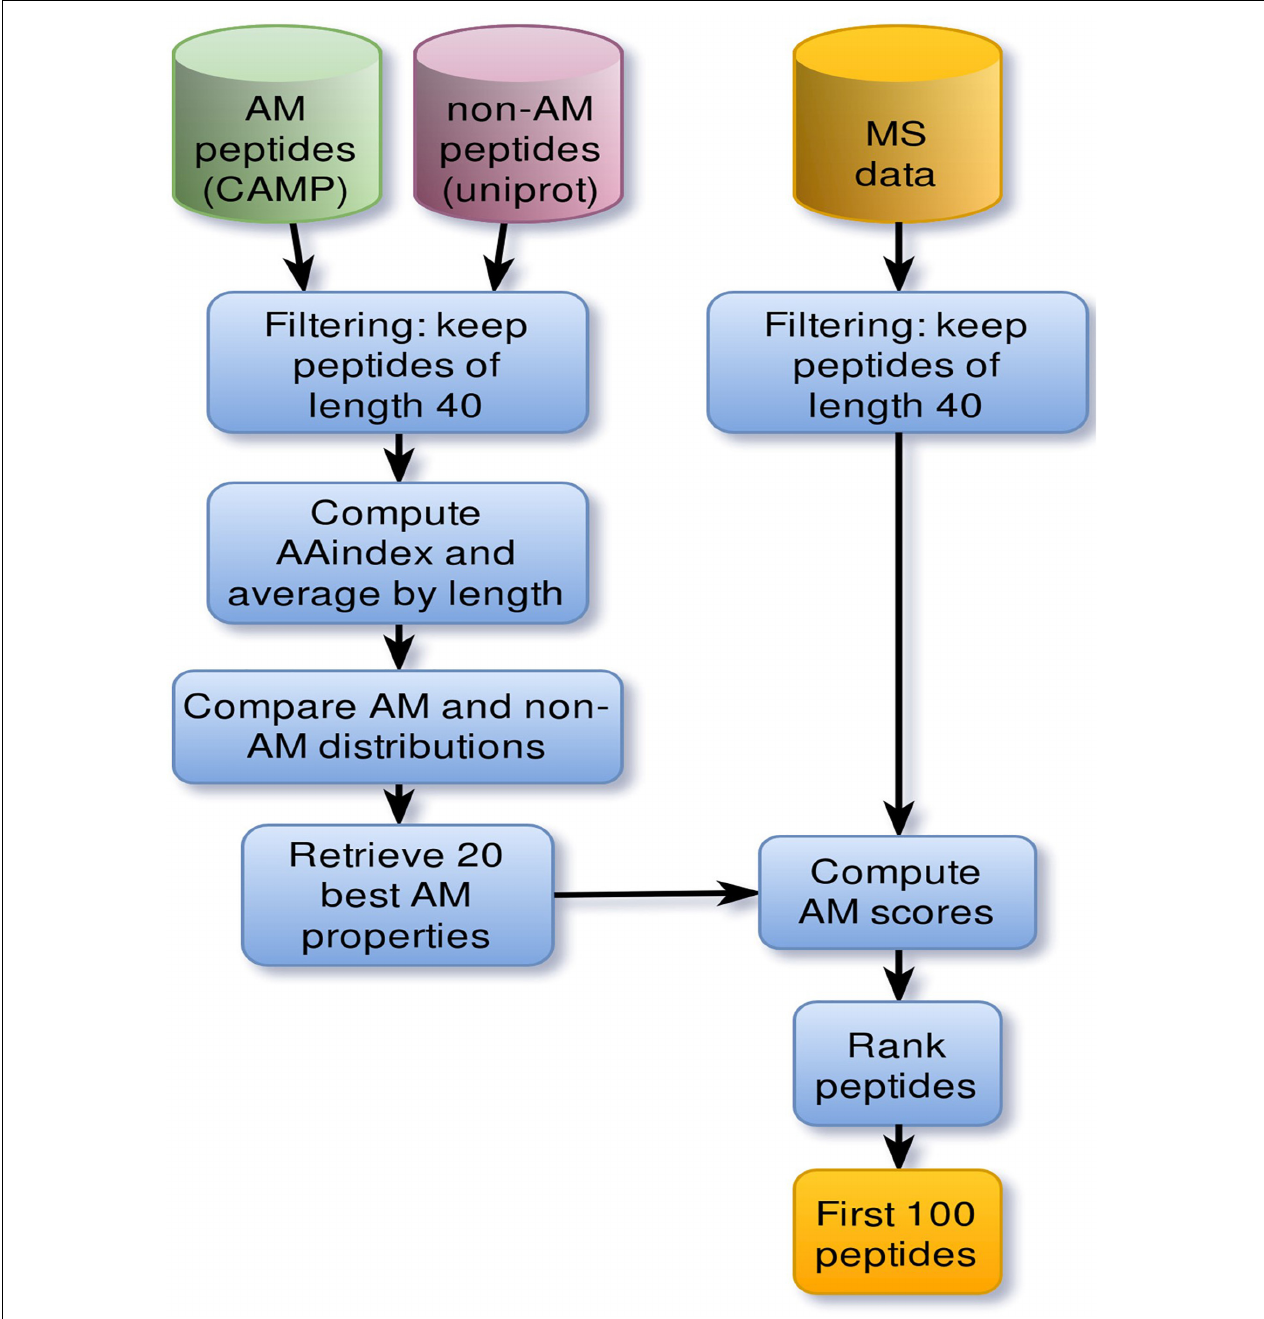
FIGURE 1 | Main steps of the pipeline that led to the discovery of NuriPep 1653. Computational steps involved in the discovery of antimicrobial related properties and AMPs. Cylinders correspond to datasets. First positive (green) and negative (red) datasets were extracted from CAMP and Uniprot databases, respectively. Sequences whose length exceed 40 amino acids were discarded based on the cut-off length for peptides. Sequence physiochemical properties were computed based on individual amino acid scores retrieved from AAindex. Those scores were then normalized by sequence length. Comparison of property distributions yielded 20 main antimicrobial properties which were subsequently used to rank mass spectrometry (MS) peptides. The resulting set of 100 peptides were then manually curated.